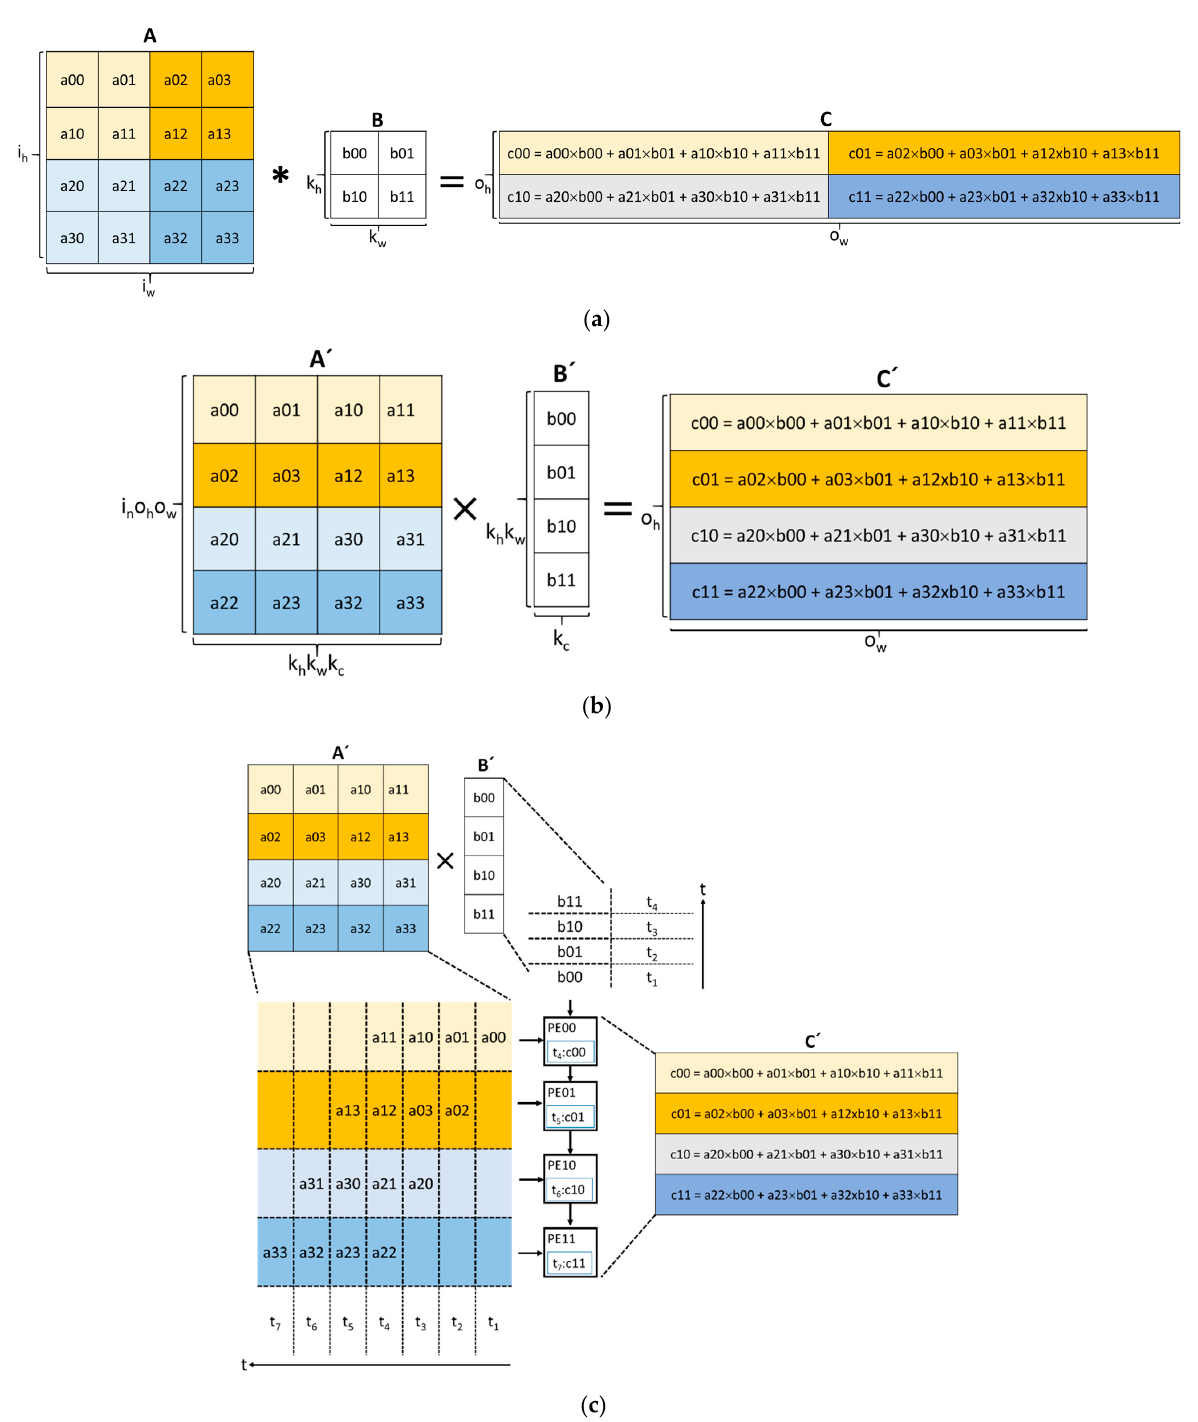
Figure 1. From convolution to systolic array computation: ( a ) direct convolution operation; ( b ) im2col-based GEMM operation; ( c ) example of a systolic array operation.